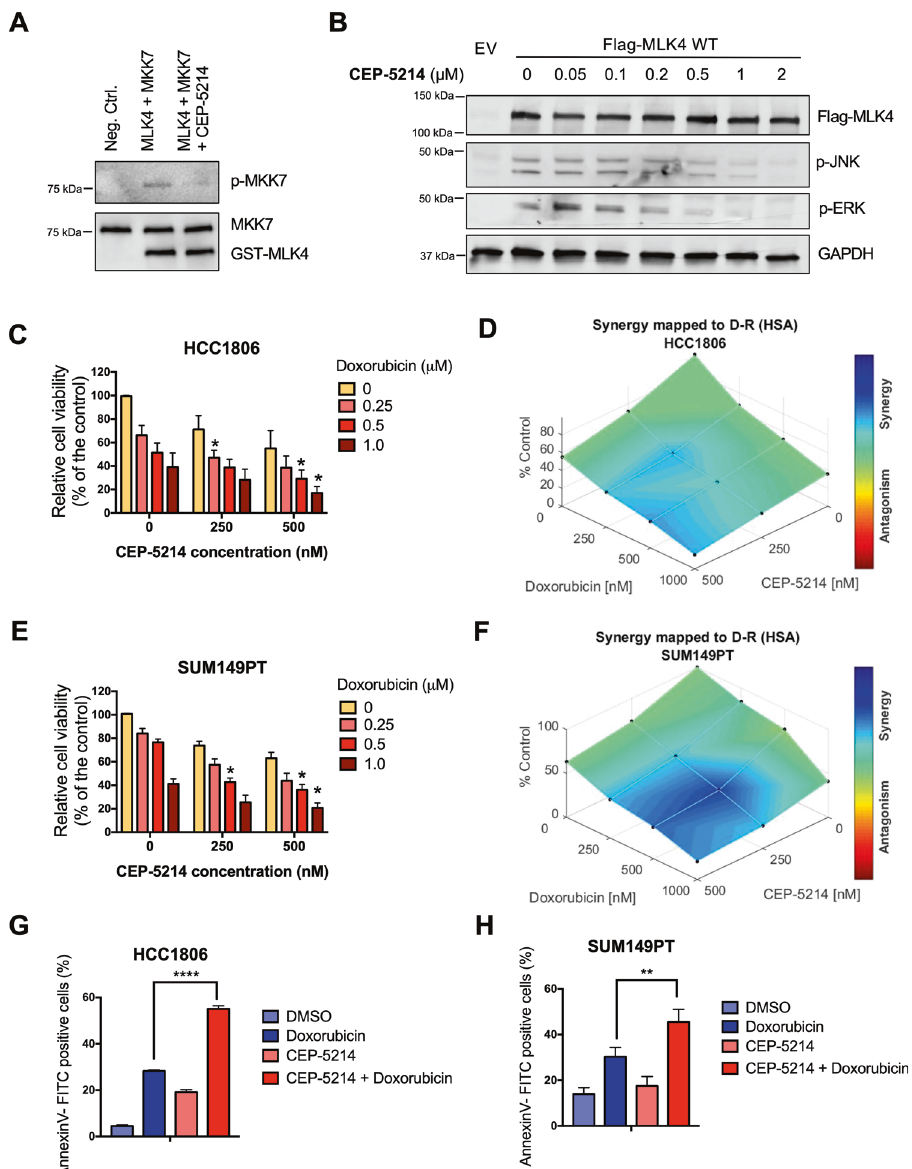
Fig. 2 MLK4 inhibition sensitizes TNBC cells to chemotherapy. A Kinase-inactive MKK7 and puri fi ed GST-MLK4 kinase domain (isolated from baculovirus-infected insect cells) were subjected to in vitro kinase assay in the presence or absence of CEP-5214 inhibitor. B HEK293T cells were transiently transfected with MLK4-WT vector or with the empty vector and incubated with increasing concentrations of CEP-5214 for 1 h. Next, whole cell lysates were collected and analyzed by immunoblotting. C – F HCC1806 (C-D) and SUM149PT (E-F) cells were incubated with CEP-5214 or DMSO for 72 h and doxorubicin for 48 h. After treatment, cells viability was assessed by crystal violet staining and quanti fi ed by absorbance measurements. Error bars indicate ±SEM from three independent experiments. Analysis of combination ef fi cacy and synergy was performed using HSA model with Combene fi t software, * p < 0.05. G – H HCC1806 and SUM149PT cells were incubated with CEP-5214 at concentrations 500 nM and 250 nM, respectively or DMSO for 72 h and doxorubicin for 48 h. Next, cells were stained with AnnexinV-FITC, and measured by fl ow cytometry. Error bars indicate ±SEM from two independent experiments, performed in triplicates. Signi fi cance was calculated using one-way ANOVA followed by Tukey multiple comparisons, ** p < 0.01, **** p <